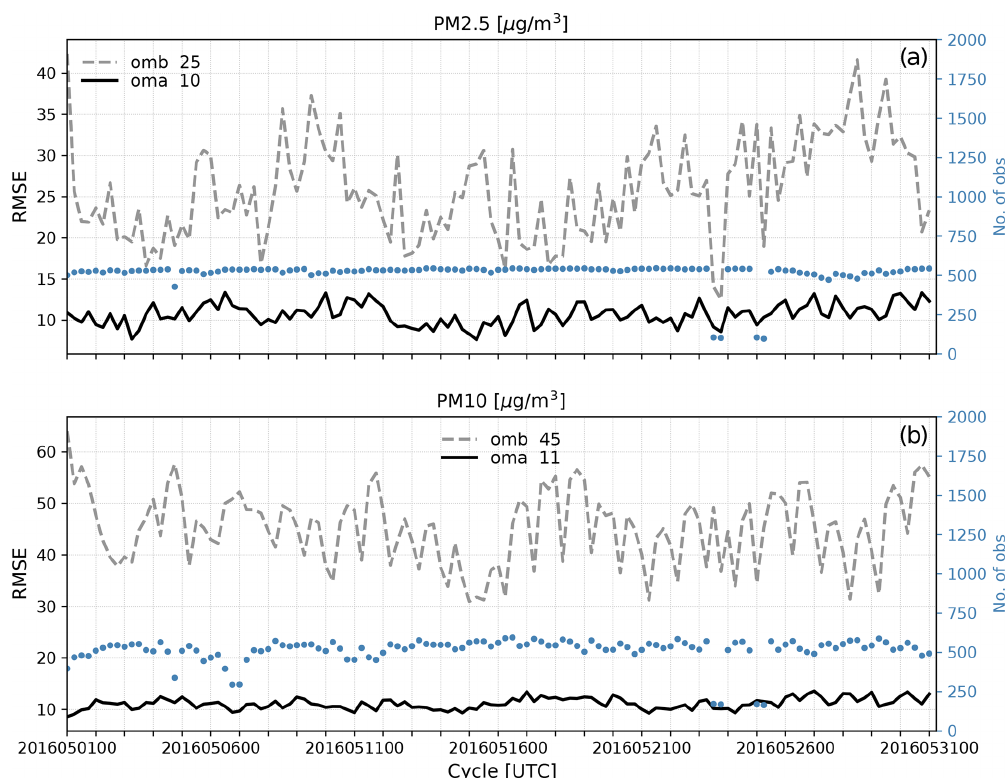
Figure 6. Time series of observation minus background (omb; dotted gray line) and observation minus analysis (oma; solid black line) in surface PM 2 . 5 (a) and PM 10 (b) in the “DA” experiment, in terms of root-mean-square error over all the stations assimilated in domain 1 at each cycle. The averages over cycles are shown in the legend, and the total number of stations at each cycle is marked in blue dots with the y axis on the